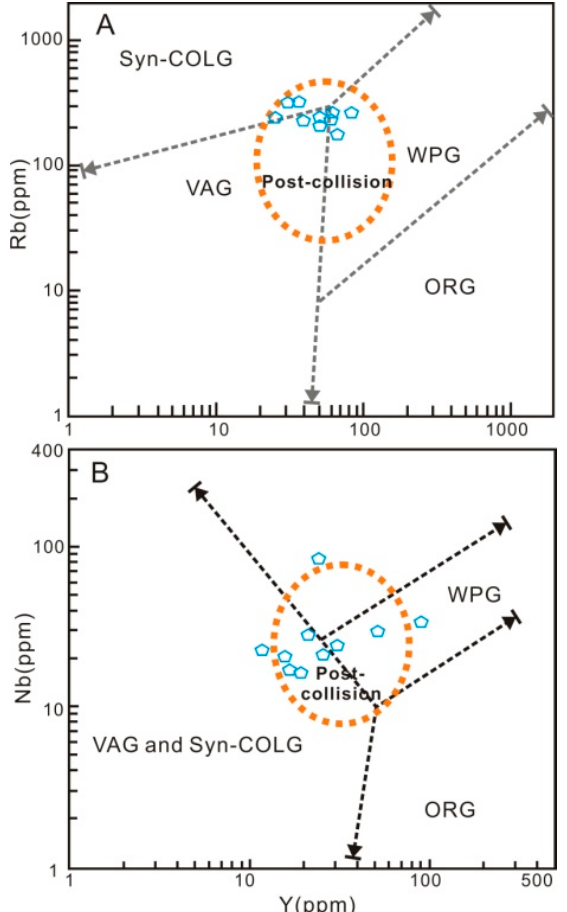
Figure 15. Discrimination diagrams for tectonic settings of BAS [67]. Abbreviations are VAG: volcanic arc granite; Syn-COLG: syn-collision granite; WPG: within-plate granite; ORG: oceanic ridge granite. Note: blue polygon represents syenite samples.